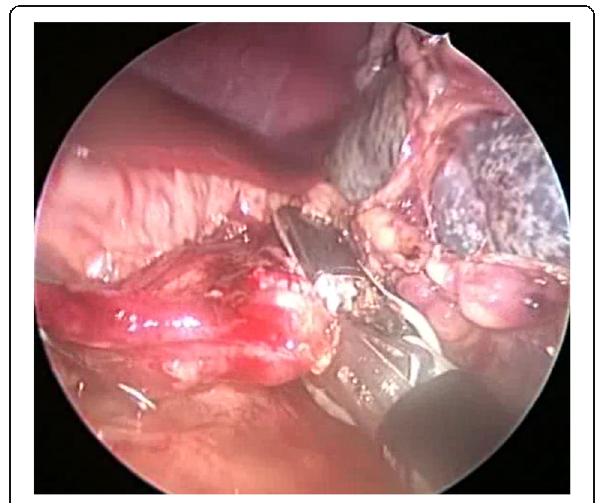
Fig. 2 The splenic vessels are then divided by